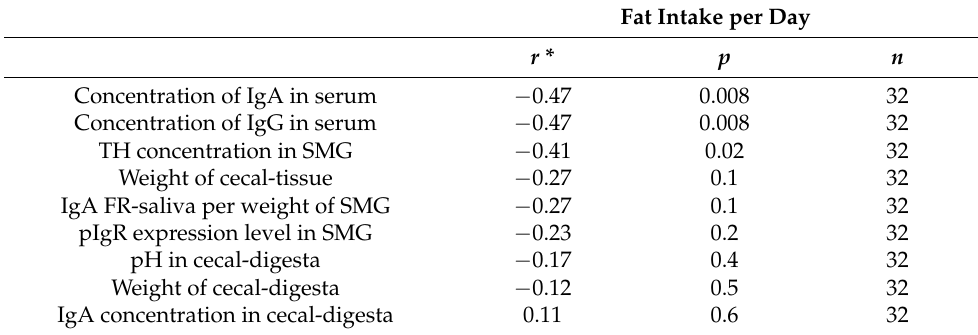
Table 4. Correlation between fat intake per day and different